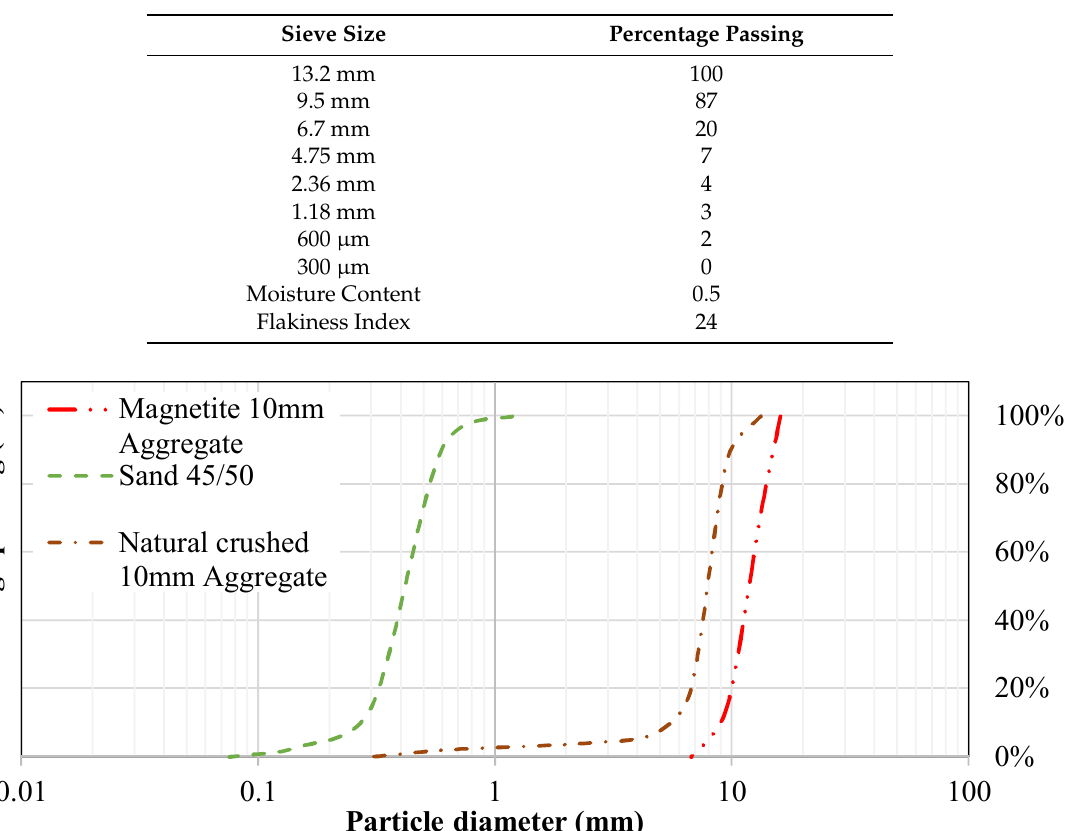
Table 5. Ten millimeter naturally crushed aggregate distribution.